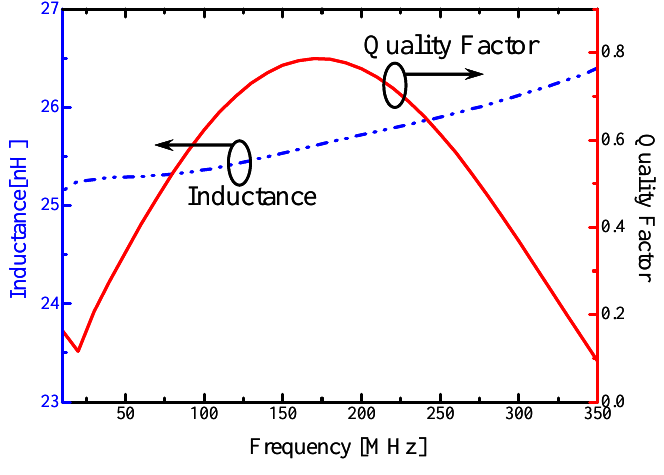
Figure 12 . The simulated Q and L of a bonding wire inductor simulated using the